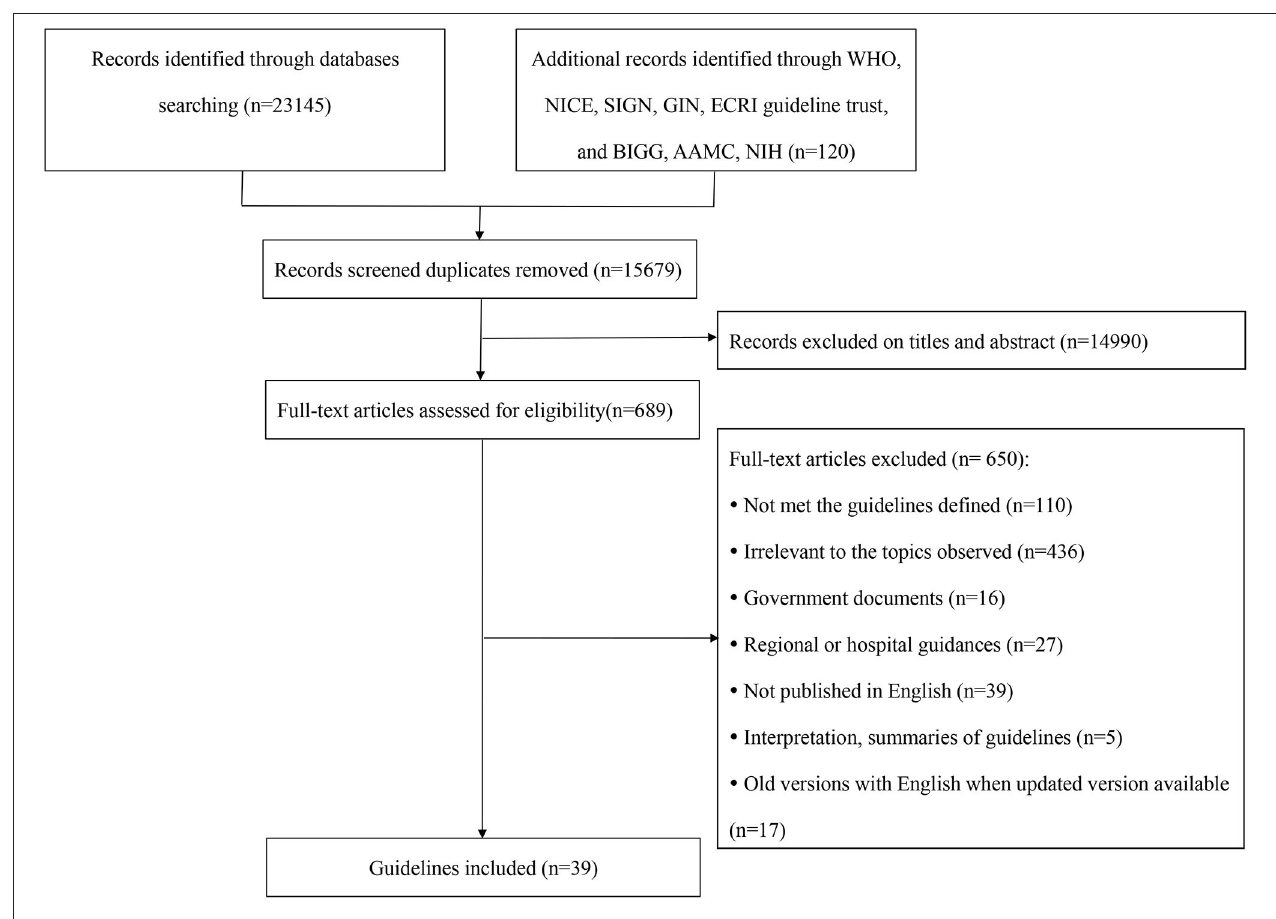
FIGURE 1 | Flow chart of guidelines identification and selection.